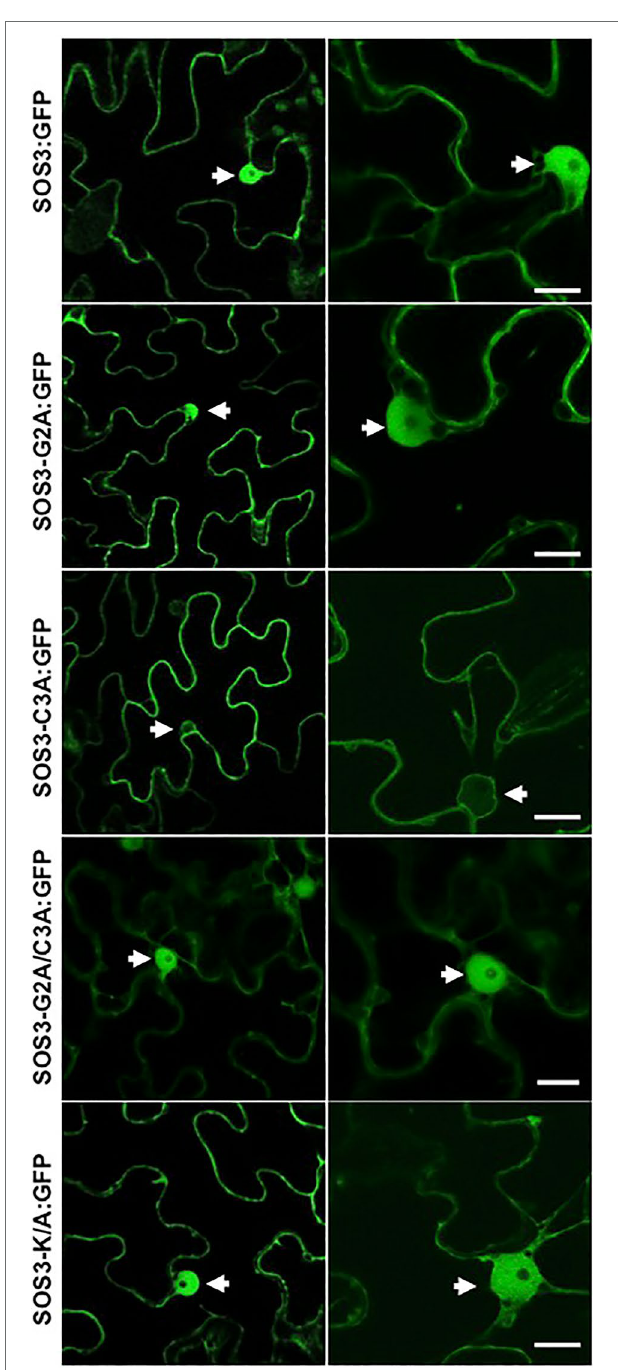
FIGURE 4 | Subcellular localization of SOS3 and mutants. The subcellular distribution of wild-type SOS3 and mutants G2A, C3A, G2A/C3A and K/A, all fused to GFP, was tested by transient expression in Nicotiana benthamiana . Left and right side panels are micrographs taken at different magnifications. Arrows indicate nuclei. Scale bars = 10 μ m.